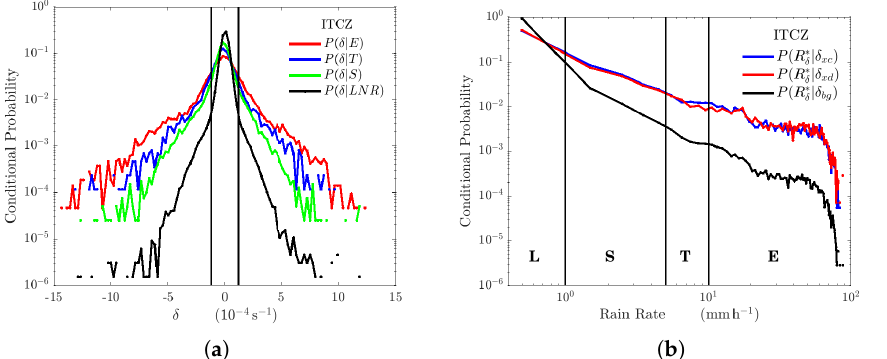
, δ ) for the ITCZ. δ